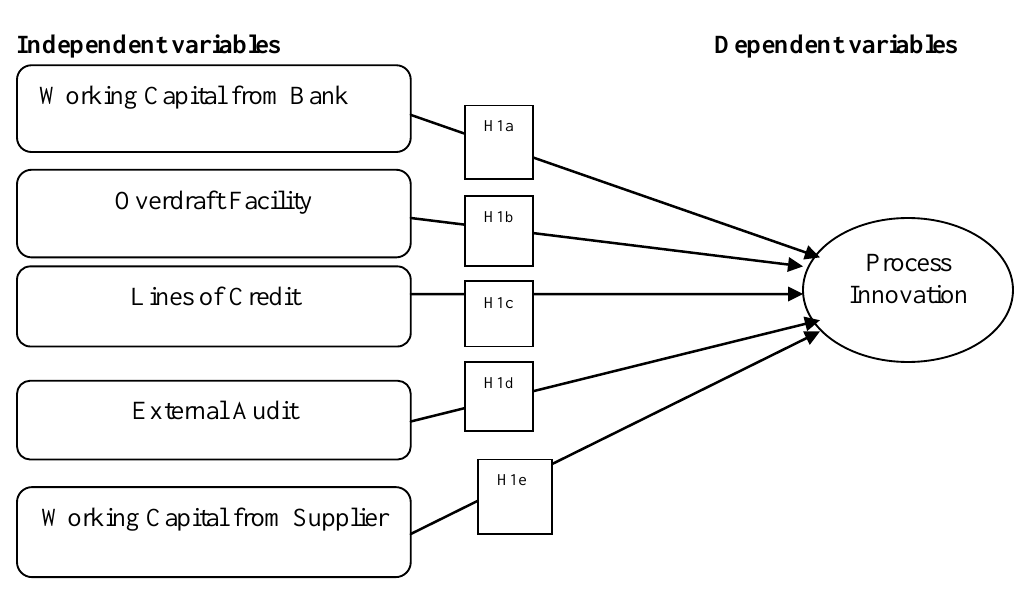
Figure 1: Theoretical Framework and